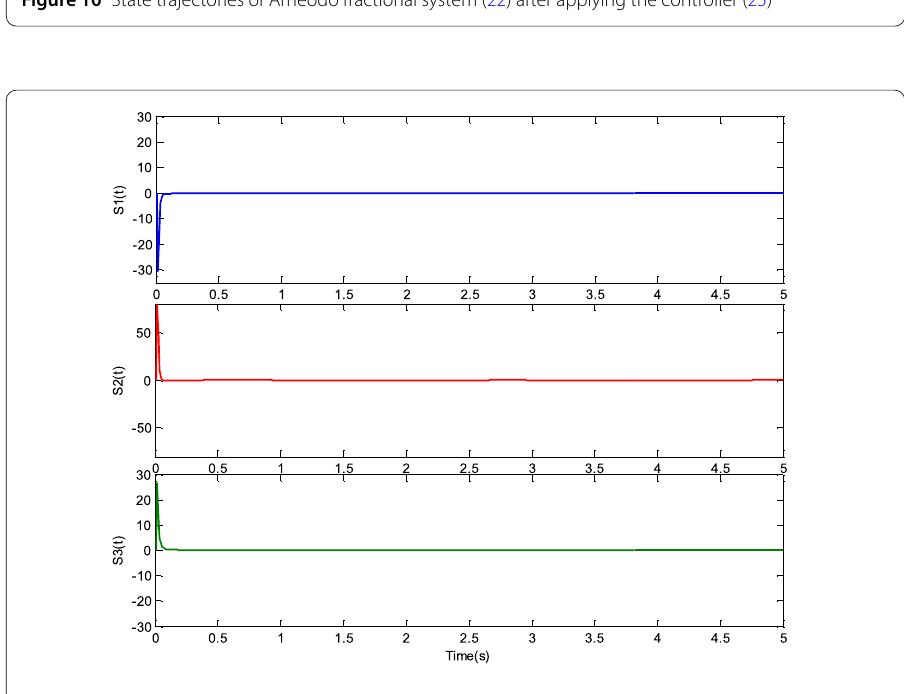
Figure 11 Stability of sliding surface